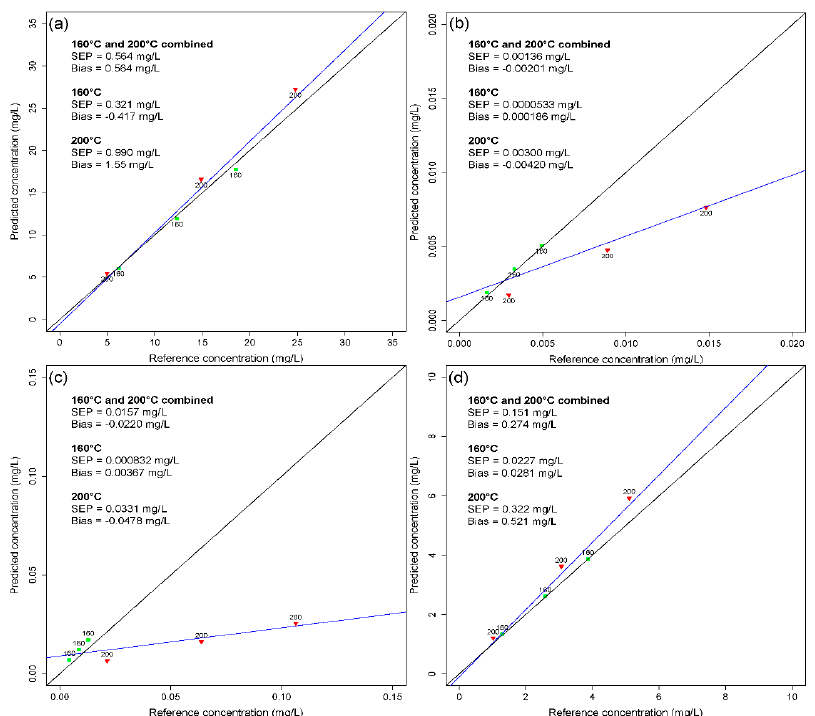
Figure 9. Application of the calibration model of data block 4 to data block 5 for ( a ) lignin, ( b ) HMF, ( c ) furfural, and ( d ) acetic acid. The pretreatment temperatures are given. SEPs and bias values are given as combined values for 160 °C and 200 °C and individually for each temperature. The regression line is in a blue color, and the 45° line is shown in black.